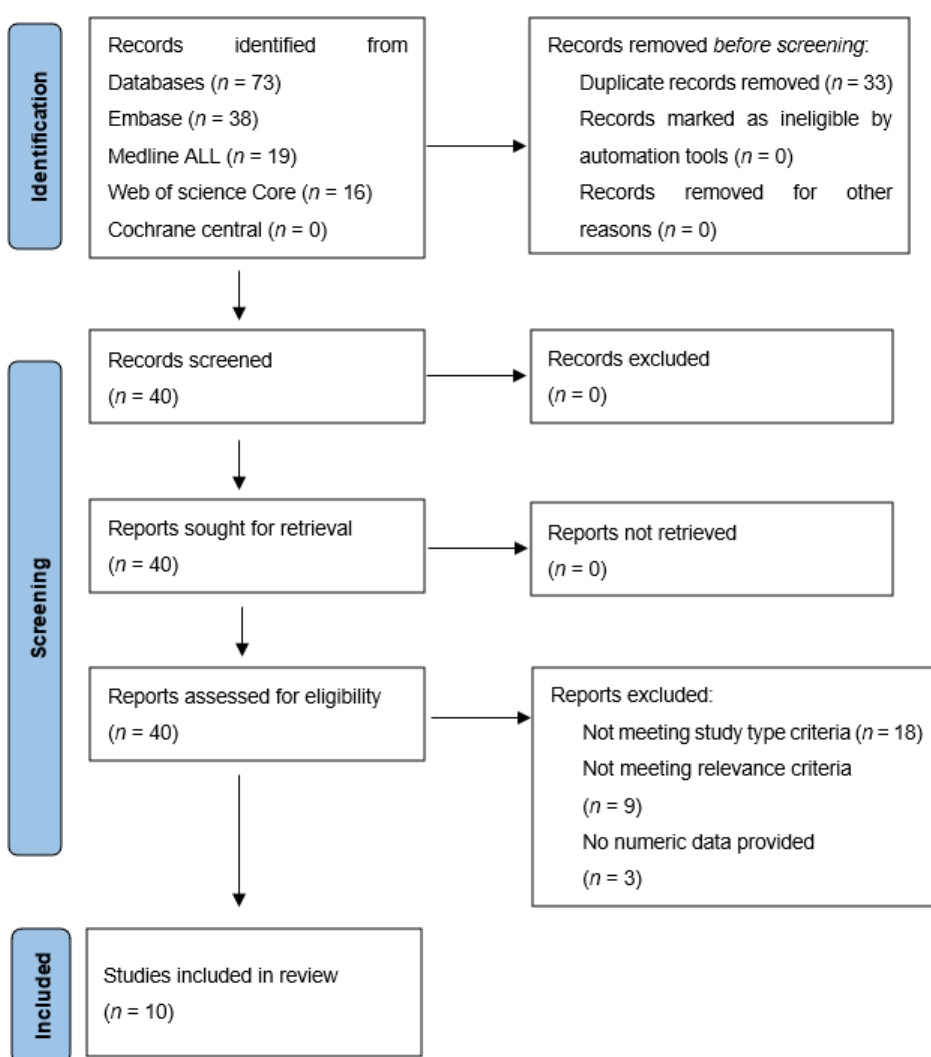
Figure 1. In- and exclusion of papers found by the literature search.